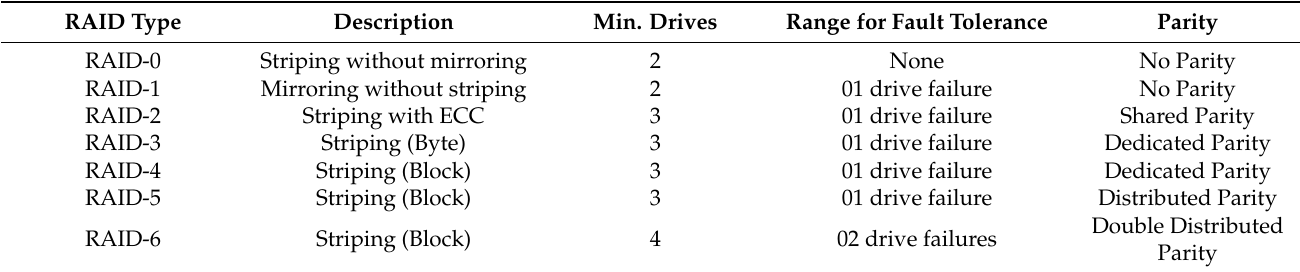
Table 1. Storage structure.